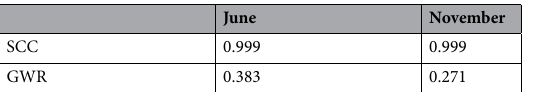
Table 3. The coefficient of determination under GWR estimation and SCC estimation.